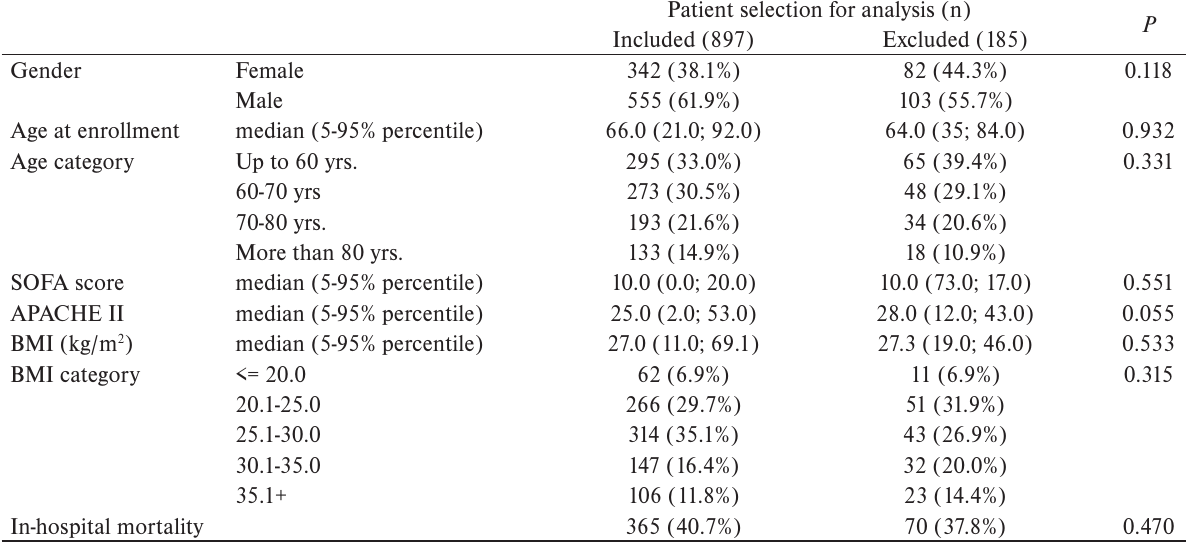
Fig. 1. Flow chart of data Table 1. Comparison of basic characteristic of patients included and excluded (incomplete data forms) from the analysis. Patient selection for analysis (n)